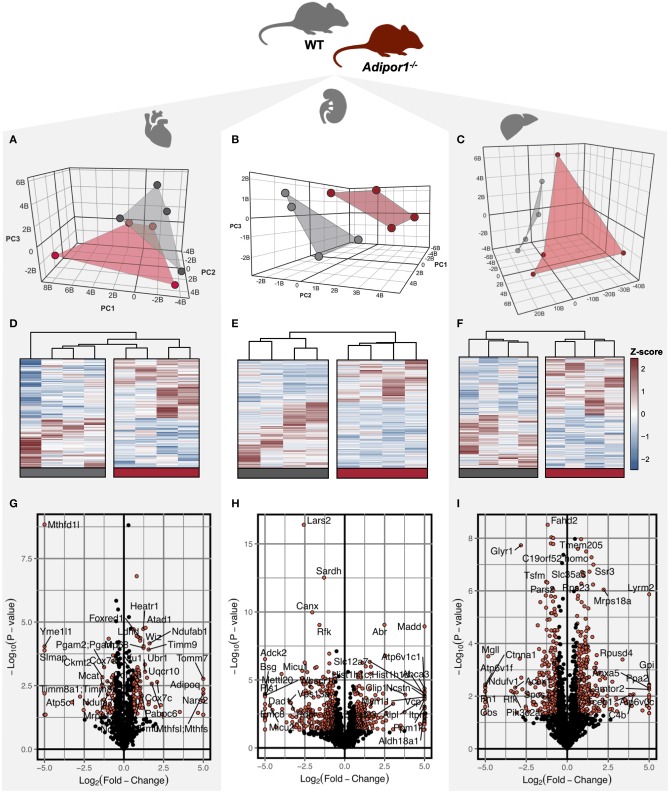
Visualization of differentially regulated proteins in mitochondrial isolates of cardiac, renal, and hepatic tissue of Adipor1−/− mice. Unsupervised three-dimensional principal components analysis (PCA) (A–C) visualization (D–F) of differentially-expressed proteins (P < 0.05), of proteomics data from Adipor1−/− mice (red) and wild-type mice (gray) for cardiac, renal, and hepatic tissues; n = 4. Volcano plots of differentially regulated proteins in mitochondria of cardiac (G), renal (H) and hepatic (I) tissue, highlighting those achieving P < 0.05 and |Fold-Change| > 1.5.